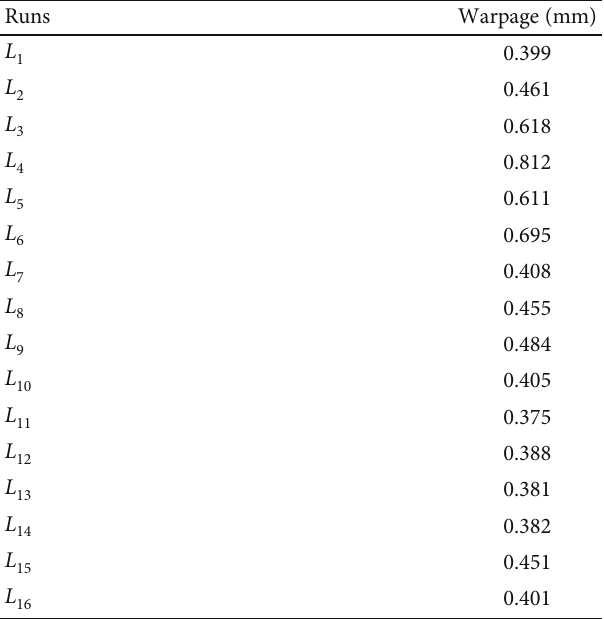
Table 3: Numerical simulation of the warpage of the thin-walled